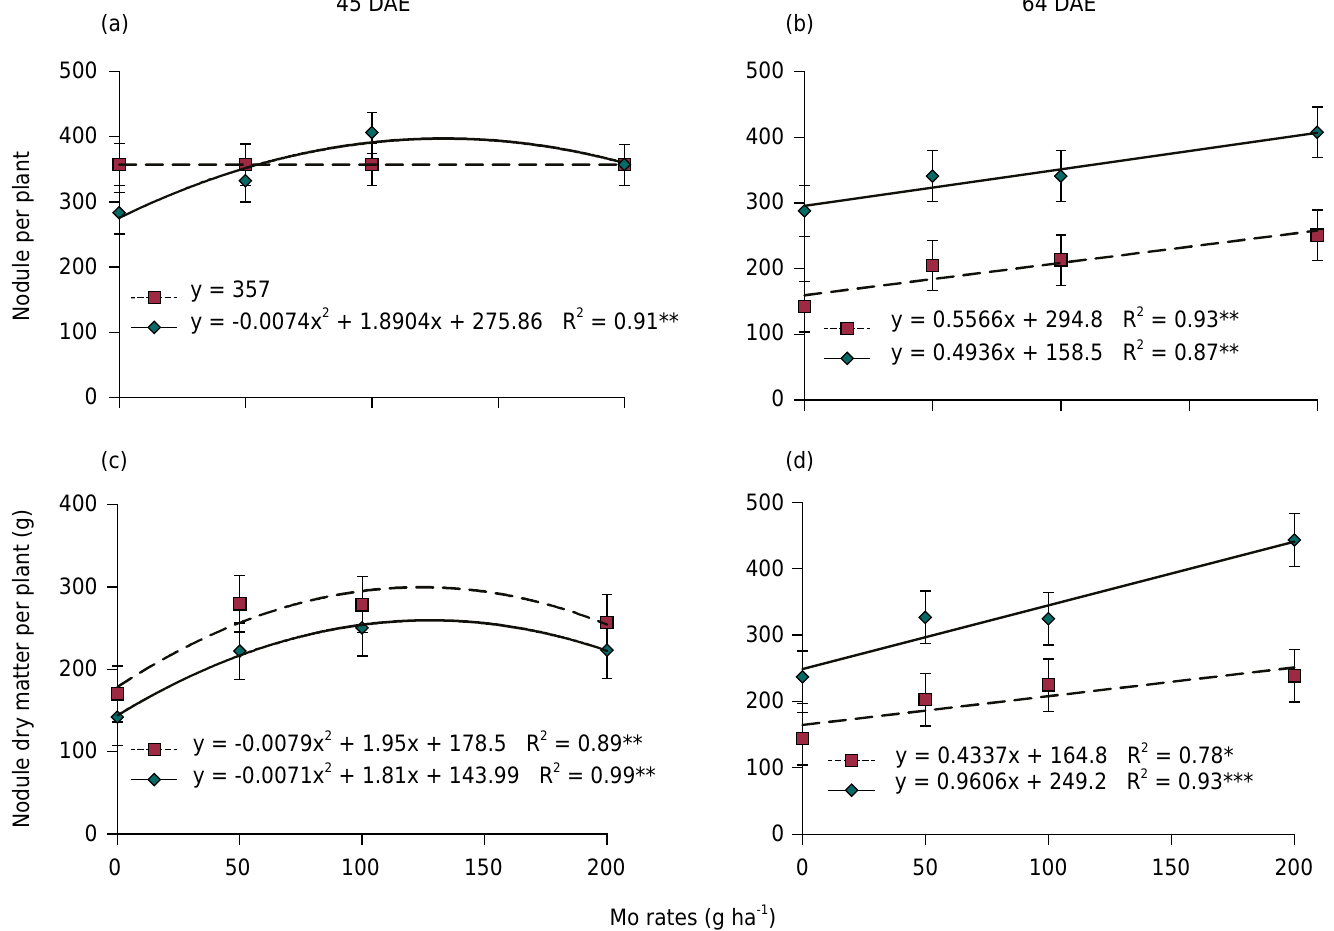
Figure 1. Number of nodules per plant (a and b) and nodule dry matter (c and d) as a function of Mo rate and rhizobial inoculation [without (□) and with (♦) inoculation] at two different stages of peanut growth (45 and 64 days after emergence, DAE). ***, **, and * are significant at p<0.01, p<0.05, and p<0.10,